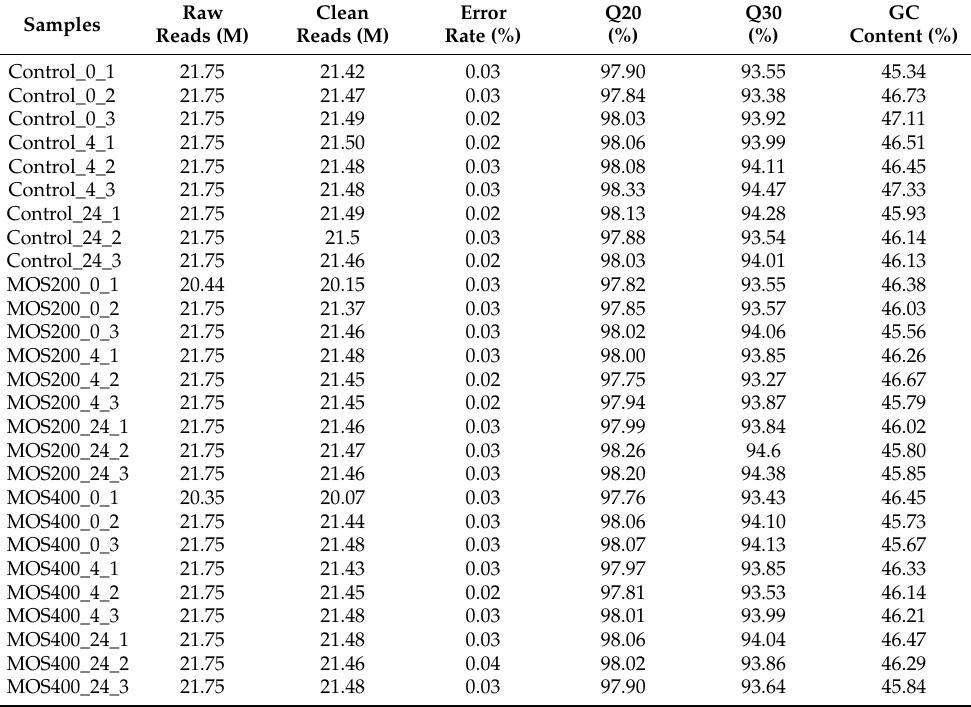
Table 1. Data quality of digital gene expression (DGE) profiling.